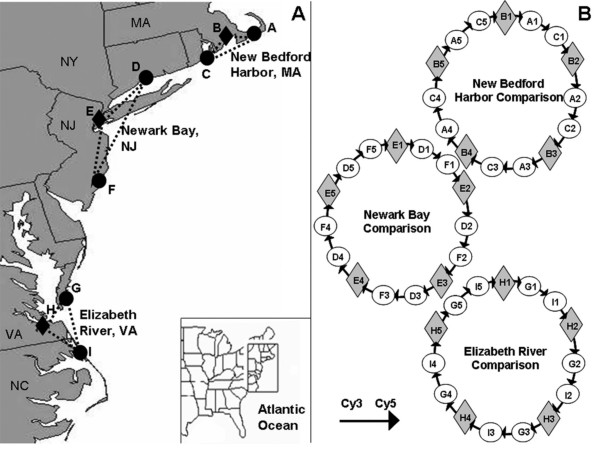
Sampling and Experimental Design. A) Map of sampling sites, USA, showing polluted Superfund Sites (diamonds, B, E and H) and reference sites (circles). Dashed triangles show the population comparisons illustrated in (B). Superfund sites have text labels. Site names, latitudes and longitudes are in Additional file 2. B) Loop design showing 5 individuals (1–5) from a polluted Superfund population (shaded diamond) hybridized with 5 individuals from each of two reference sites (circles). This experiment used 3 loops and 15 individuals per loop for a total of 45 individuals hybridized to 45 arrays. Each individual is labeled with both Cy3 and Cy5 dyes. Spots are replicated 4 times per array.